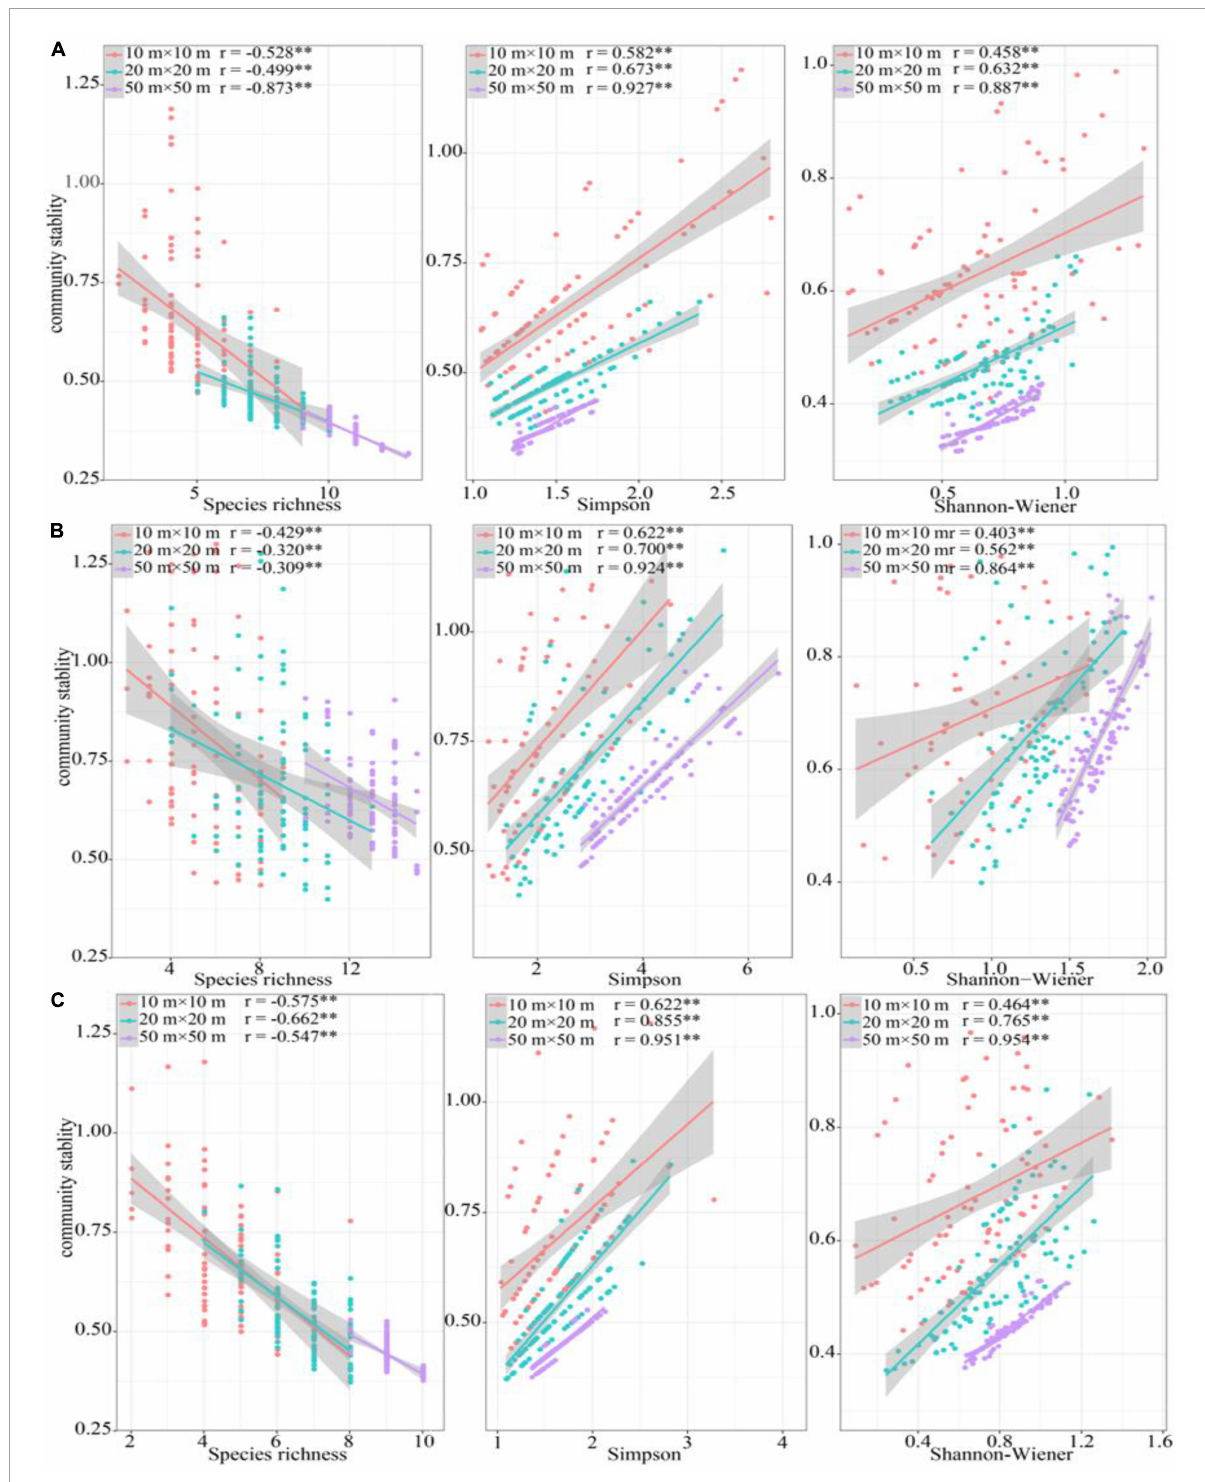
FIGURE5 Relationship between species diversity and community stability. (A) riparian forest, (B) ecotone community, (C) desert shrubs. * P < 0.05, ** P < 0.01, *** P < 0.001.